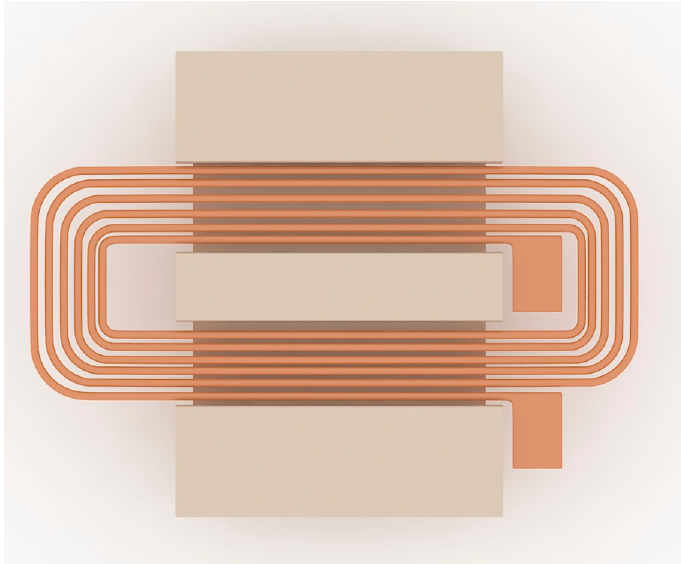
Figure 4. Sandwich structure with electroplated NiFe as the magnetic core.